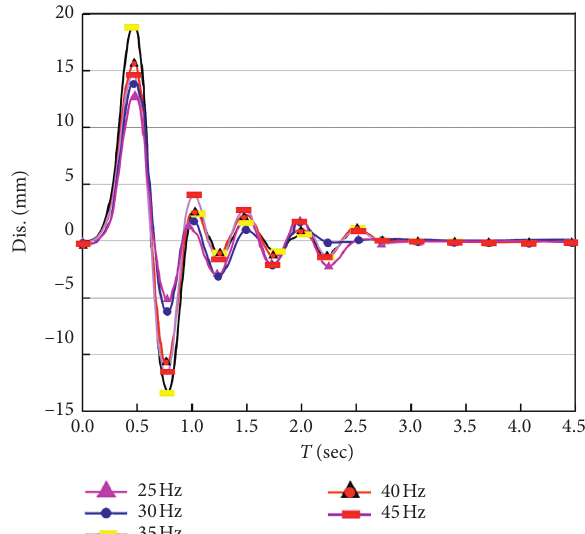
Figure 7: Displacement-time history curves of a point at the slope surface under the action of vibration waves of different vibration